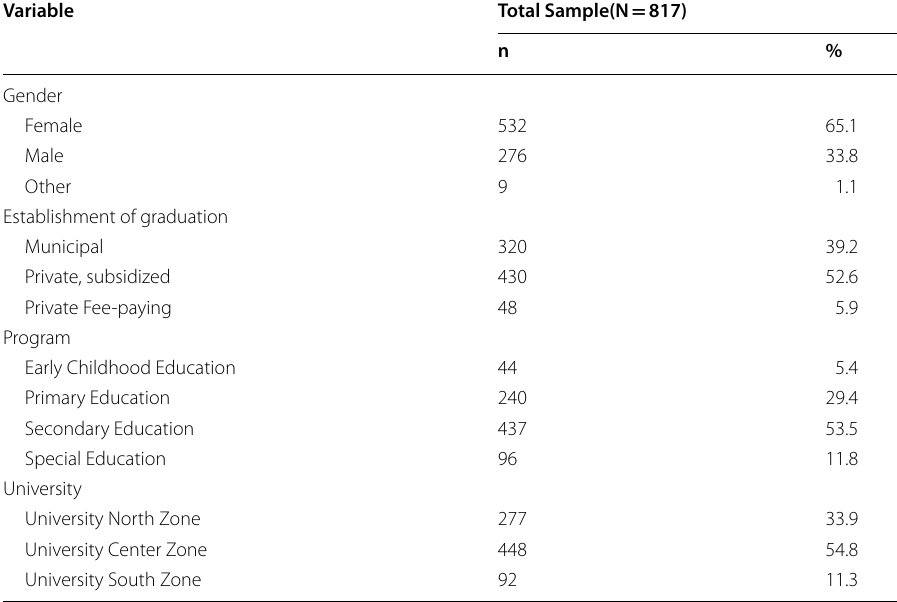
Table 1 Sample characterization. Source: Prepared by the autor